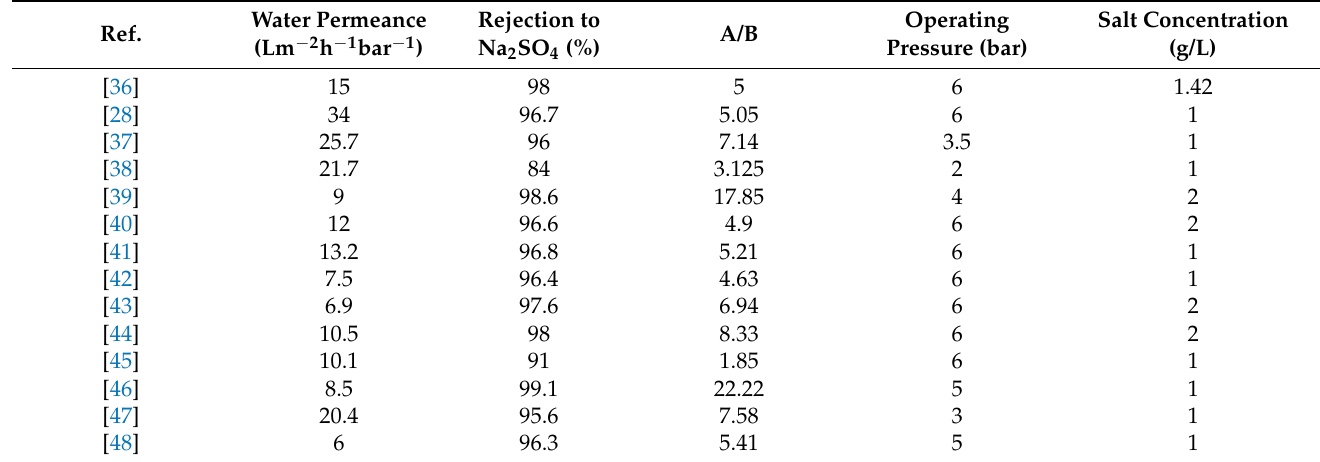
Figure S4: SEM cross-section images of TFC − Control and SA–TFC membranes, Figures S5–S9: XPS full spectrum and the C, N, O, Ca peak fitting spectra of TFC membranes, Figure S10: The influence of thermal treatment time on nanofiltration performance of